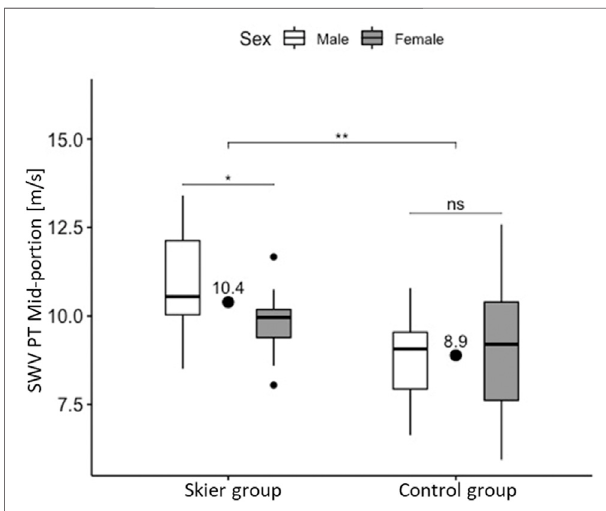
FIGURE 2 | Shear wave velocity of the midportion of the patellar tendon as a function of group membership and sex. ( Median, interquartile range, range and outliers (*): p < 0.05 (**): p < 0.01 (ns): p > 0.05.